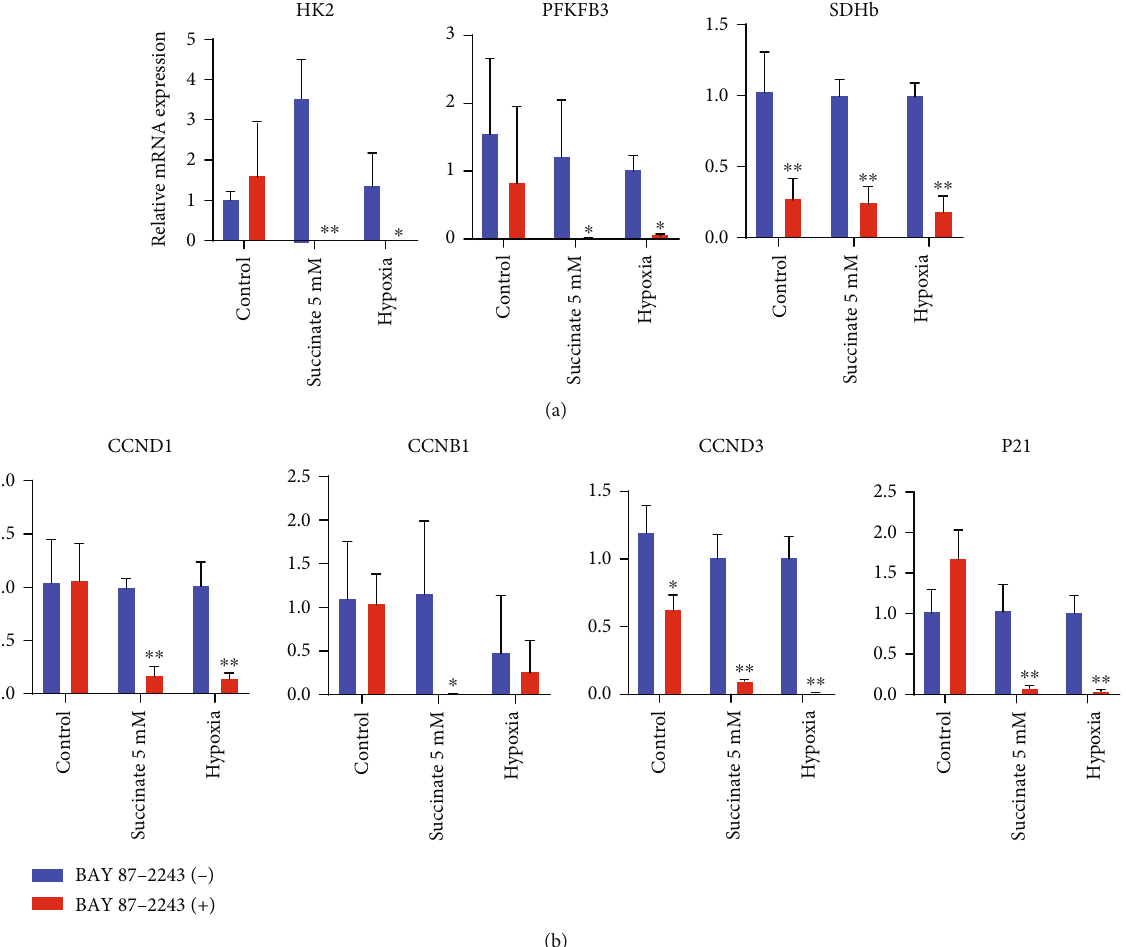
Figure 5: Blocking HIF-1 α a ff ected genes that were involved in glycolysis and proliferation of hPDLCs during hypoxia incubation and succinate supplementation. hPDLCs were preconditioned with BAY 87-2243 to block HIF-1 α for 3 h. Changes in metabolic and cell cycle-related genes at 4h after hypoxia/succinate treatment were measured by qPCR ( n = 4 ) (a, b). ∗ p < 0 : 05 , relative to control; ∗∗ p < 0 : 01 , relative to